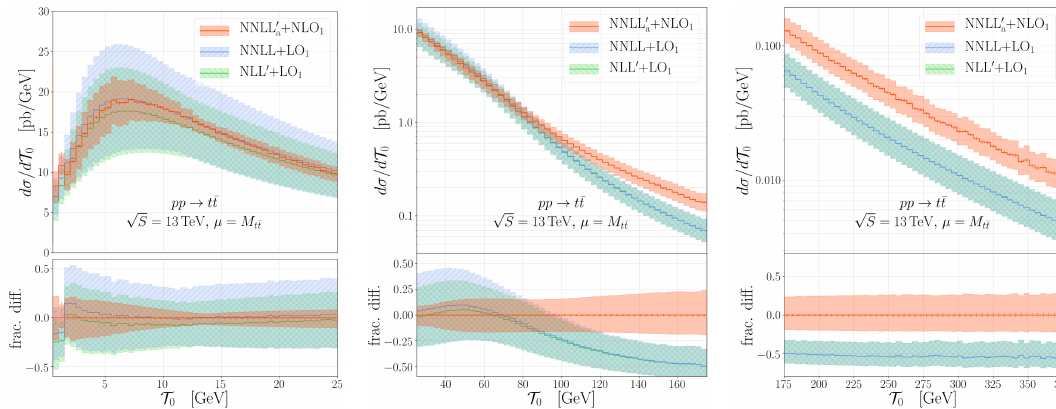
Figure 5 . Resummed predictions matched to the appropiate fixed order for the T 0 distribution at increasing accuracy in the peak (left), transition (centre) and tail (right)